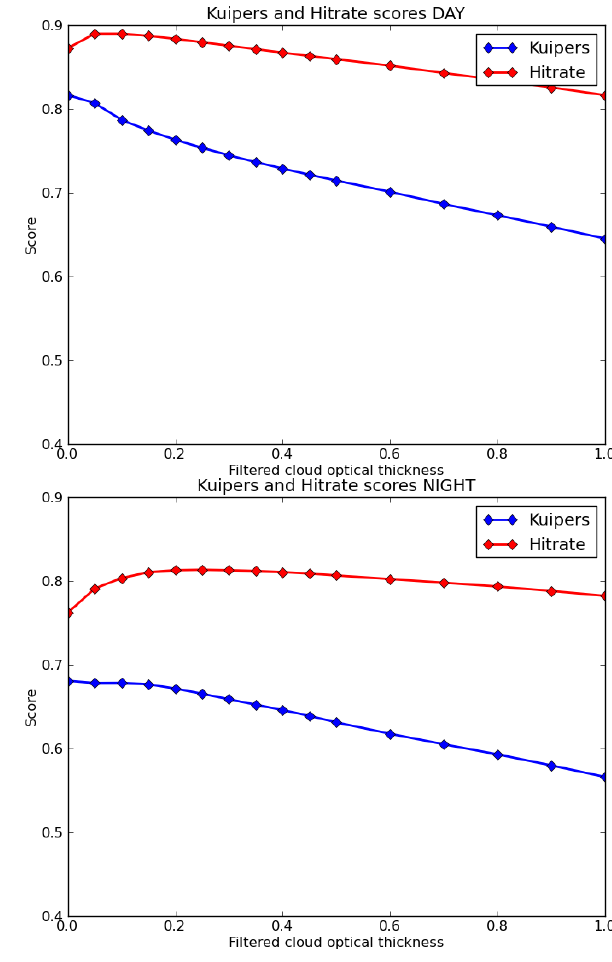
Fig. 11. Same visualisation as in Fig. 8 but for categories day (top) and night (bottom).